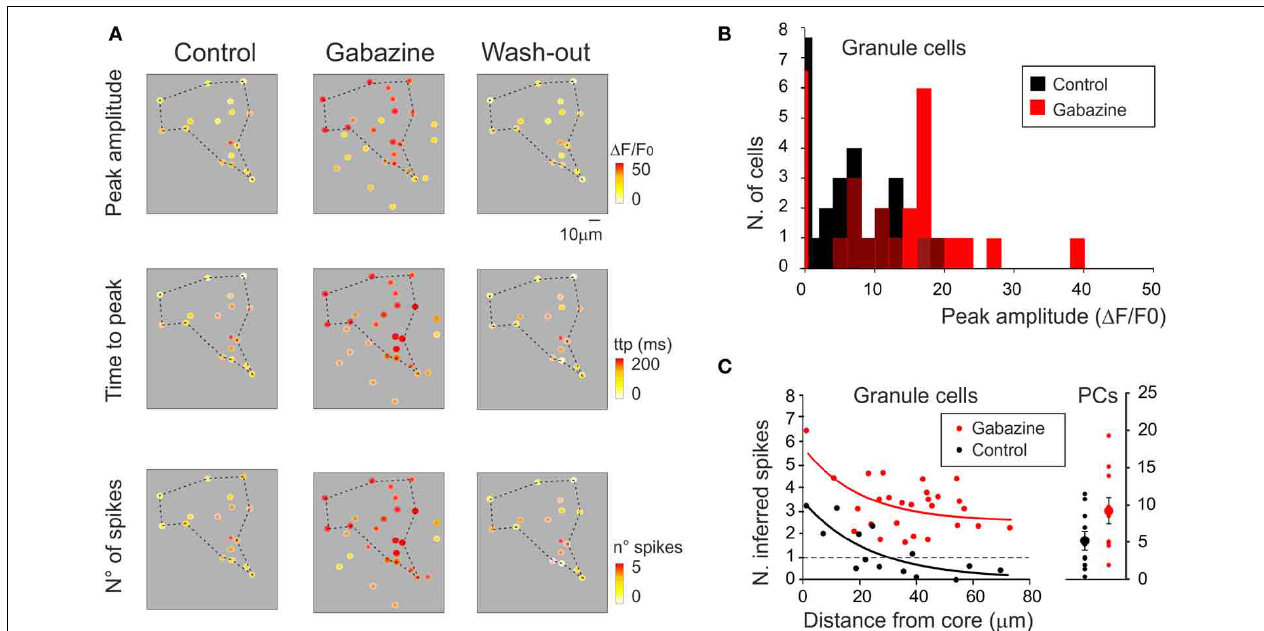
FIGURE 9 | Cerebellar circuit responses III: predictions of neuronal firing. (A) Activity maps of the granular layer (same recordings as in Figure 8A ) showing the peak intensity of neuronal responses on a color scale. The location of colored dots corresponds to that of neurons in the slice. The panels show that both the activation intensity (upper panels), the time to peak of the response (middle panels) and the inferred number of emitted spikes (lower panels) increase remarkably applying gabazine and revert to control conditions after wash-out. (B) The histogram shows the probability of occurrence of response amplitudes in the cell population analyzed in (A) . Note the shift of the distribution toward larger amplitude after gabazine application. (C) The plot (on the left) shows the relationship between the